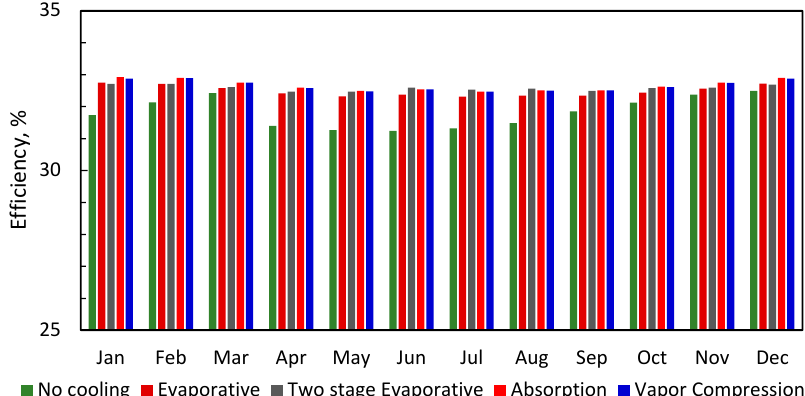
Figure 15. Effect of inlet cooling on gas turbine efficiency.